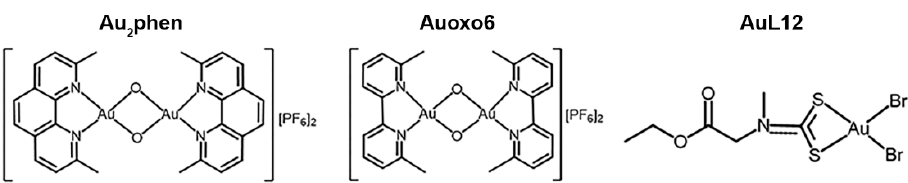
Figure 1. Chemical structure of the investigated gold(III) compounds: Au 2 phen ((2,9-dimethyl-1,10-phenanthroline) 2 Au 2 (µ-O)2)(PF 6 ) 2 , Auoxo6 ((6,6 ′ -dimethyl-2,2 ′ -bipyridine) 2 Au 2 (µ-O) 2 )(PF 6 ) 2 and AuL12 (dibromo(ethylsarcosinedithiocarbamate)gold(III)).